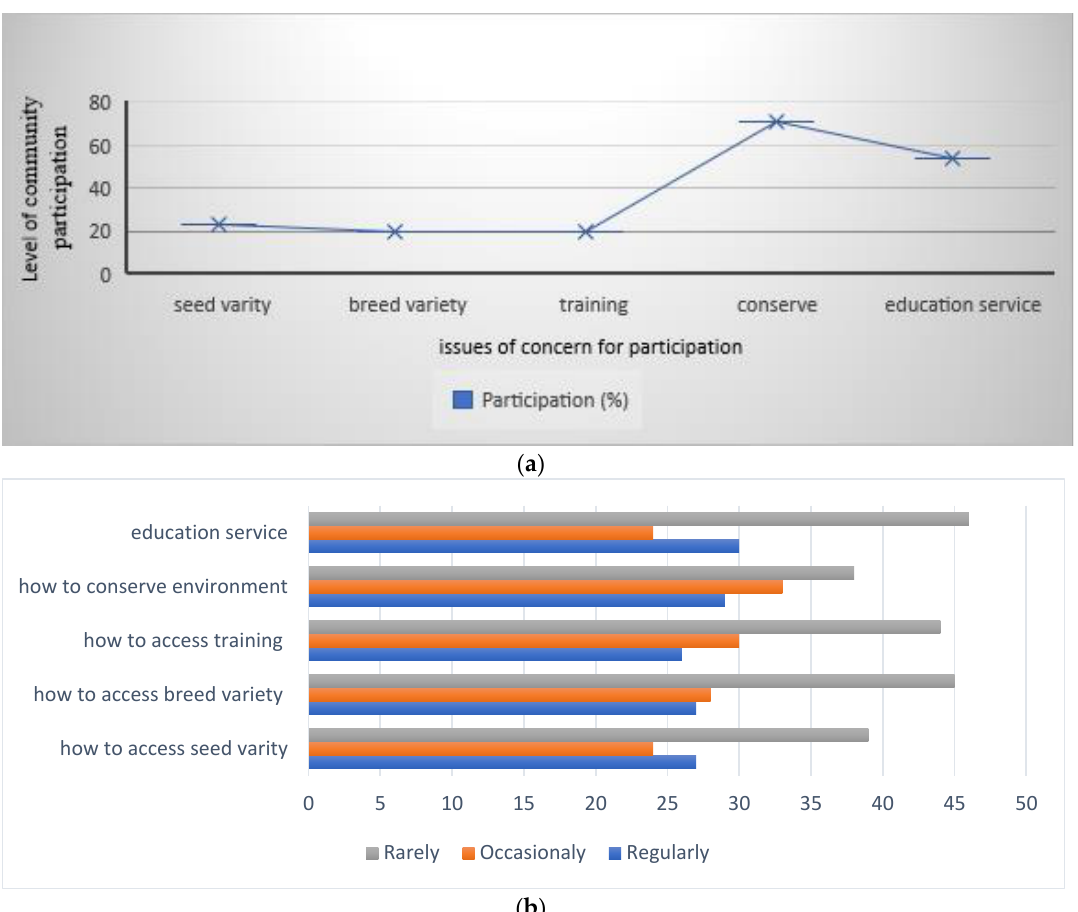
Figure 5. Level and frequency of community participation in the making of procedures for local-level climate adaptation. ( a ) Level of participation. Source: a household survey (March–May 2020). ( b ) The frequency of participation. Source: a household survey (March–May 2020).